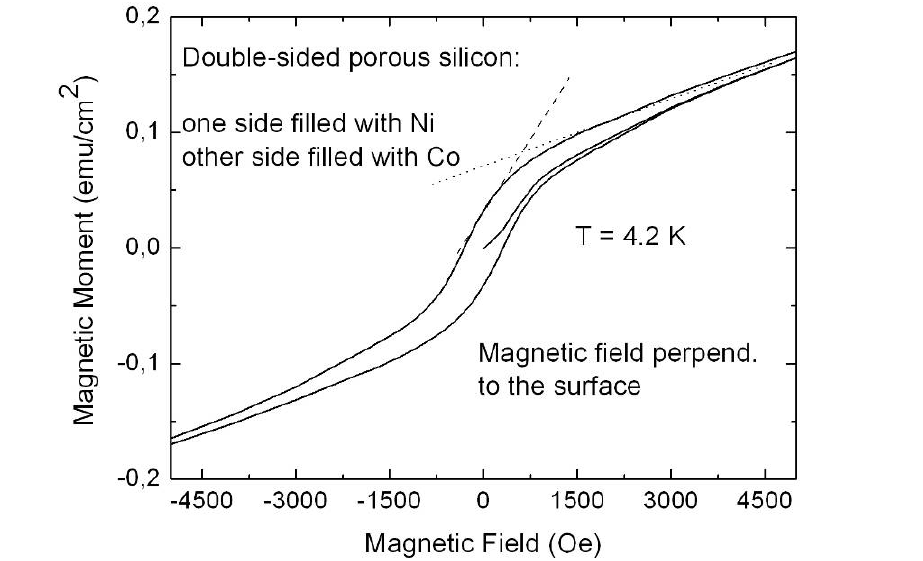
Figure 29. Magnetization measurements performed on a double-sided etched porous silicon sample whereas the two porous layers are filled with Ni on one side and Co on the other one. The two metals offer a distinct saturation magnetization and thus the hysteresis loop shows two different